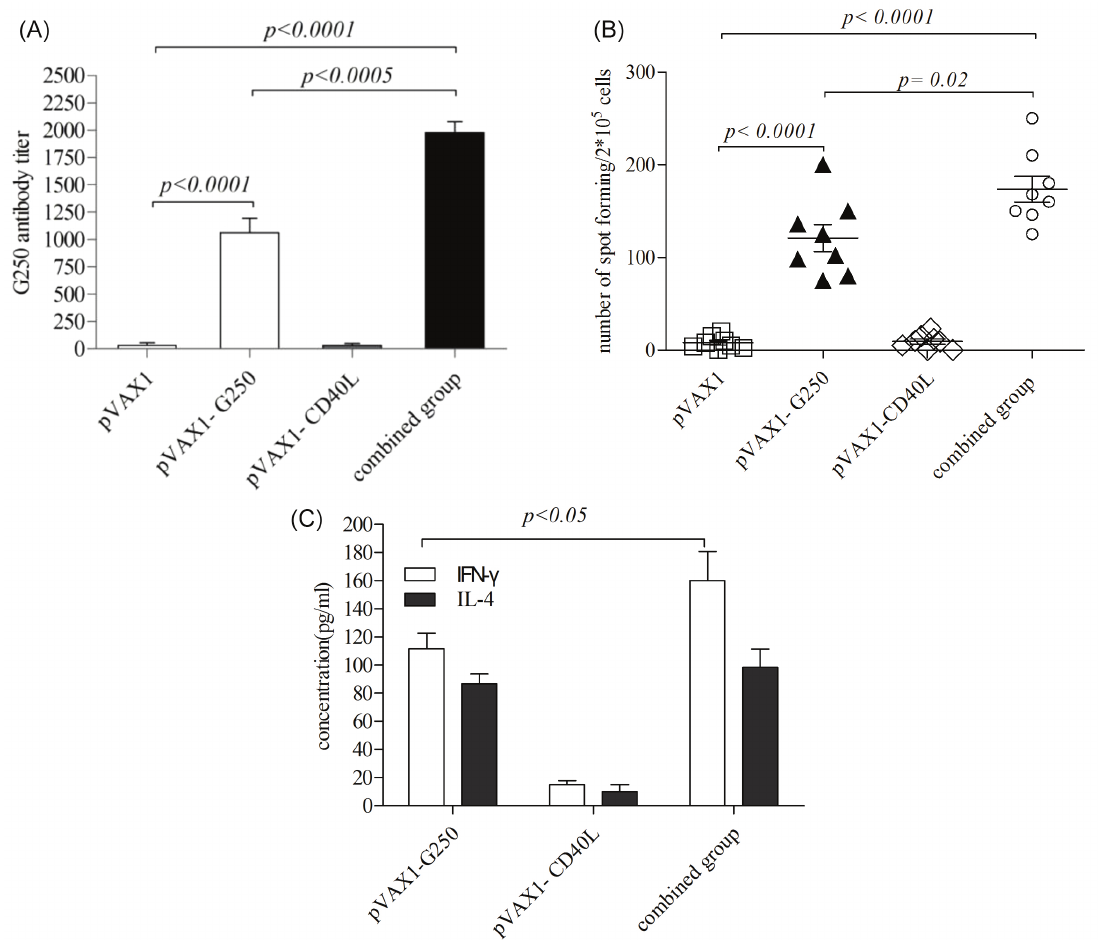
FIGURE 3 - Antibody and T cell responses induced by immunization with the recombinant DNA plasmids in mice. (A) Anti-G250 antibodies were detected by ELISA. (B) Analysis of spot frequencies of G250-specific IFN-γ-producing T cells. (C) Cytokine profiles of proliferating T cells. Data are presented as mean ± S.D.